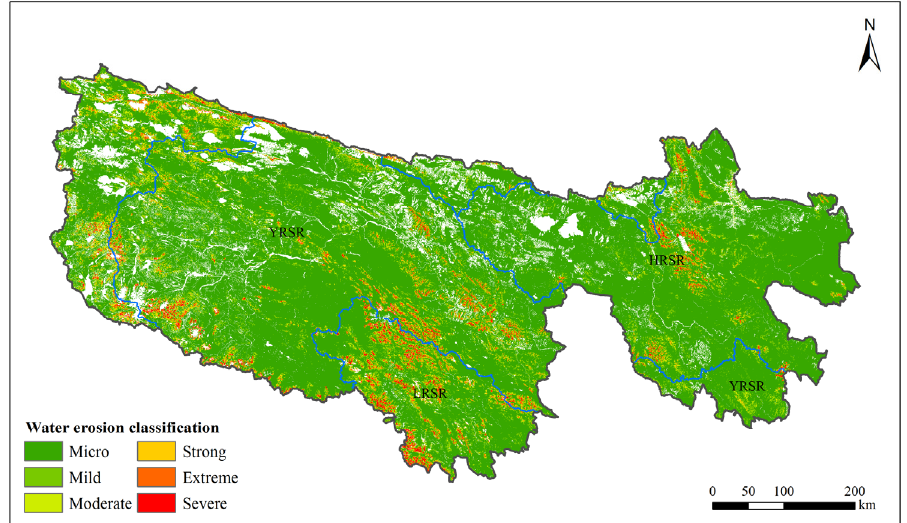
Figure 3. The soil water erosion classification from 2000 to 2020 in the TRHR, China.